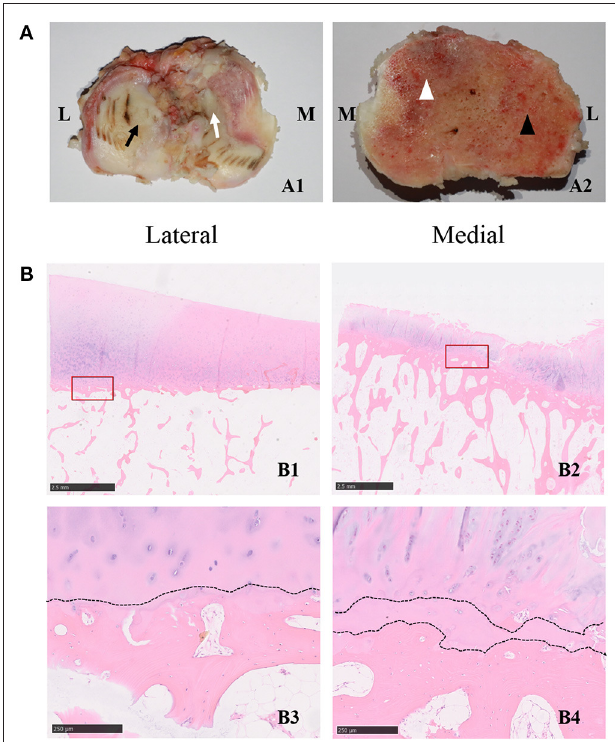
FIGURE 1 | (A,B) Histological characterizations of the cartilage and subchondral bone in the tibial plateau of OA specimens. (A1) The characterizations of the cartilage in different compartments. The black arrow indicates the less-worn cartilage, while the white arrow indicates the severe-worn cartilage in the medial compartment. M indicates the medial compartment of the knee joint, and L indicates the lateral compartment of the knee joint. (A2) The characterizations of the subchondral bone in different compartments. The white arrowhead indicates the severe-degenerative subchondral bone, the black arrowhead indicates the mild-degenerative subchondral bone in the lateral compartment. M indicates the medial compartment of the knee joint, and L indicates the lateral compartment of the knee joint. (B1) Representative hematoxylin and eosin staining images of specimens in the lateral compartment of knee joint. The scale bar represents 2.50mm. (B2) Representative hematoxylin and eosin staining images of specimens in the medial compartment of the knee joint. The scale bars in B1,B2 represent 2.50mm. The bottom two panels (B3,B4) are high-magnification images of the red frame in B1 and B2 , respectively, the dotted line indicates the tideline. The scale bar represents 250 um. The right panel (B4) is a high-magnification image of the red frame in (B2) , and the dotted lines indicate the duplicated tideline. The scale bar represents 250